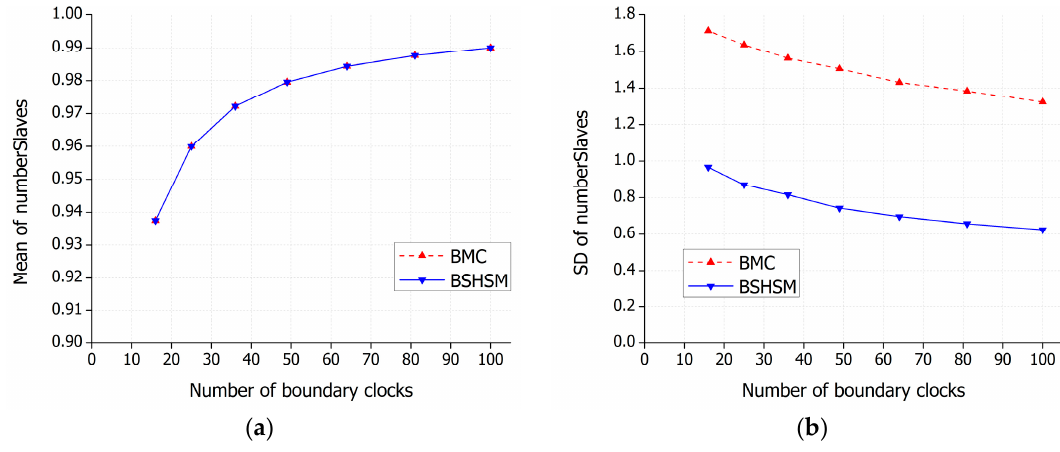
Figure 11. The mean and SD values of the numberSlaves attribute in simulation 2. ( a ) The mean value of the numberSlaves attribute; and ( b ) the SD of the numberSlaves attribute.